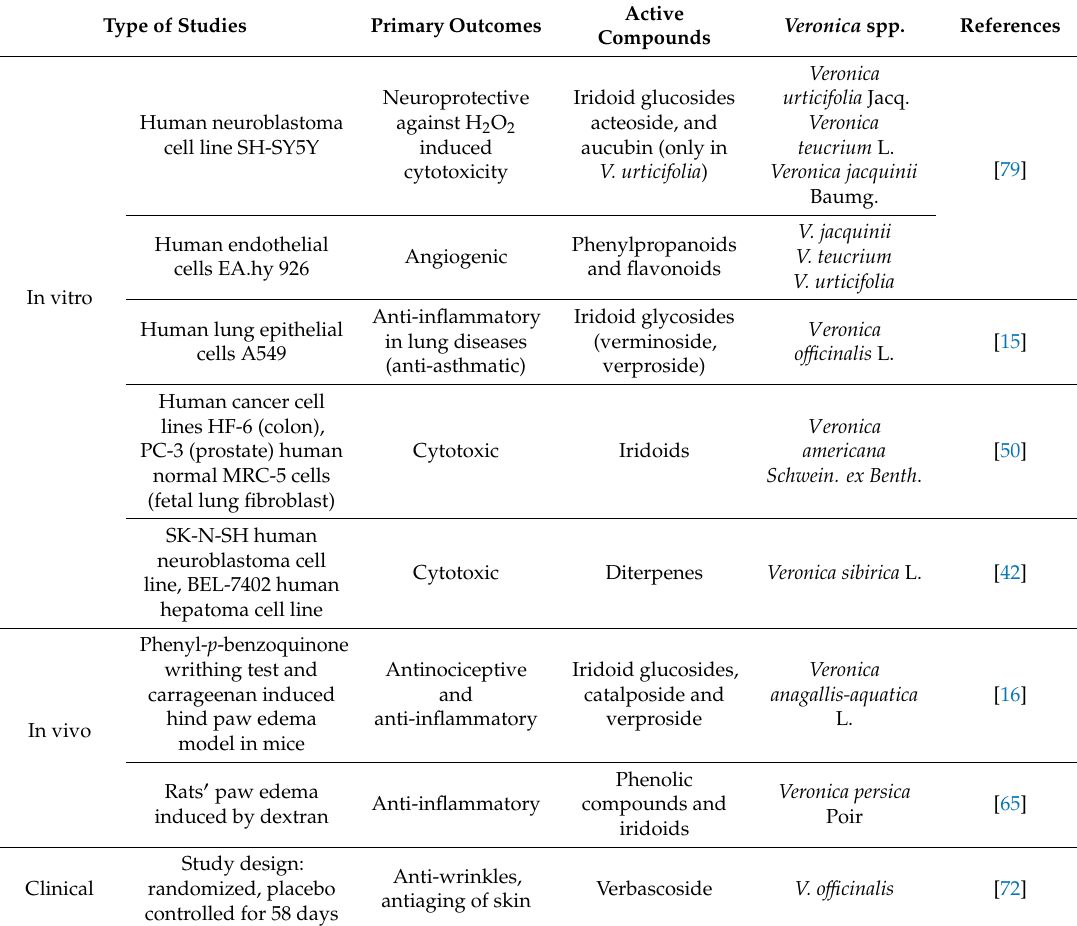
Table 4. Some bioactive e ff ects of Veronica plants and potential active